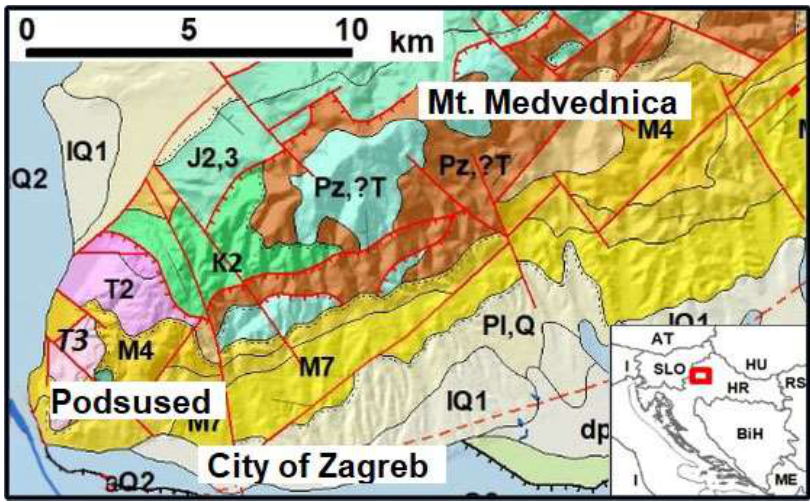
Figure 3. Geological relationships of the Neogene deposits and the pre-Neogene basement rocks in the central and SW parts of Medvednica mountains. Legend for geology, after [17]: Pz, ?T—Paleozoic to Triassic parametamorphites; T2—Middle Triassic limestones and dolomites; T3—Upper Triassic dolomites; K2—Upper Cretaceous carbonate clastics; M4, M7—Neogene deposits; Pl, Q, IQ1, Q2—